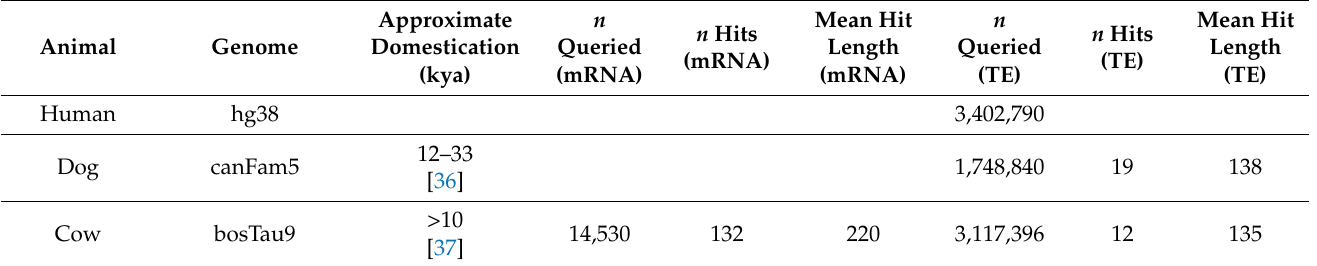
Table 1. Summary values for human vs. domesticated animal pairwise megablasts performed to identify signatures of recent retrotransposon HT. Pairwise megablasts of reference mRNA were performed for a subset of species as a positive control for vertical inheritance. TE: transposable element; kya: thousands of years